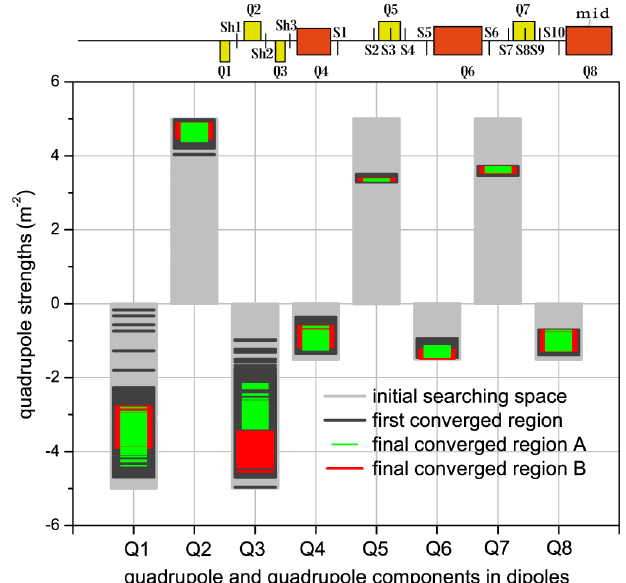
FIG. 1. The quadrupole strengths and the quadrupole compo- nents of the dipoles. Q1, Q2, and Q3 are the quadrupoles in the dispersion-free section, Q5 and Q7 are the quadrupoles in the dispersion section, while Q4, Q6, Q8 are the quadrupole com- ponents in the dipoles. The light grey dots are the initial search- ing spaces of each quadrupole magnet, the dark grey dots are the first time converged region, and the multicolor dots are the second time convergence regions. All of these converged regions satisfy the design emittance goal: " x < 0 : 075 nm rad